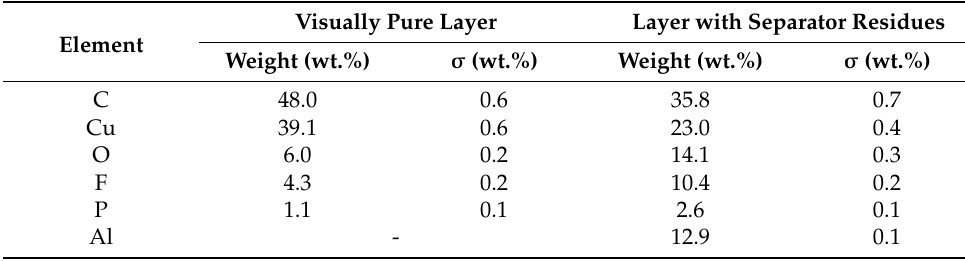
Figure 5. The anode of the battery cell: ( a ) cross-section of a graphite double layer on Cu foil with an illustration of materials layer thickness; ( b ) EDS element map of visually pure layer; ( c ) EDS element map of graphite layer with separator residues. The sample surface of anode materials was x-rayed in EDS mode; the elemental maps 235 for the visually pure layer and spinel with separator residues are shown in Figures 5 (b) 236 (containing F and P) and confirmed the presence of a separator (based on Al). The material 238 layer was determined to be >90% pure graphite based on the results of XRF analysis. 239 Table 3. Results of the EDS element map for the battery anode. Element